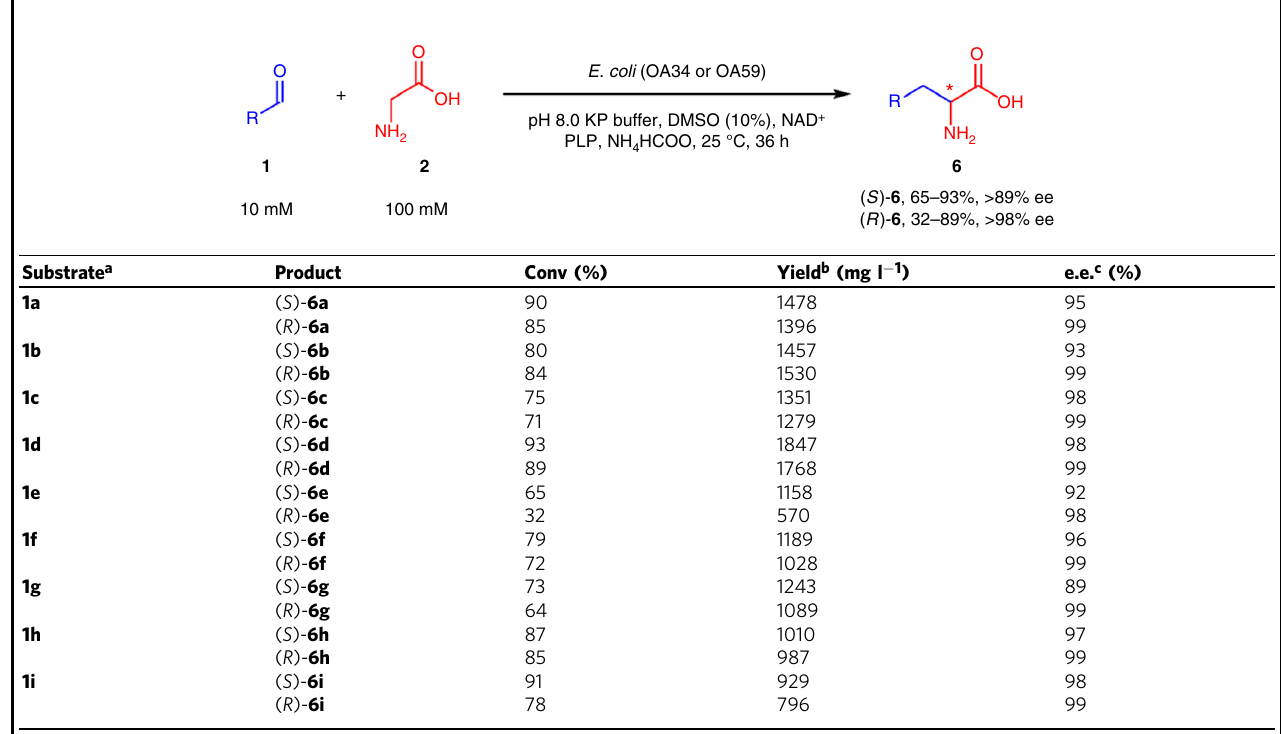
a Reactions were performed in duplicate with resting cells of E. coli (OA34 or OA59) (10g dcw l − 1 ) and 1a – i (10mM) in 2ml KP buffer (50mM, pH 8.0, 100 µ M PLP, 1mM NAD + , and 10% DMSO) at 200rpm and 25°C for 36h b The conversion and yields were obtained after completion of the reactions and determined by HPLC analysis. The values are averages of two experiments c Enantiomeric excess (e.e.) was determined by chiral HPLC analysis (Supplementary Figs 19-26). The values are averages of two